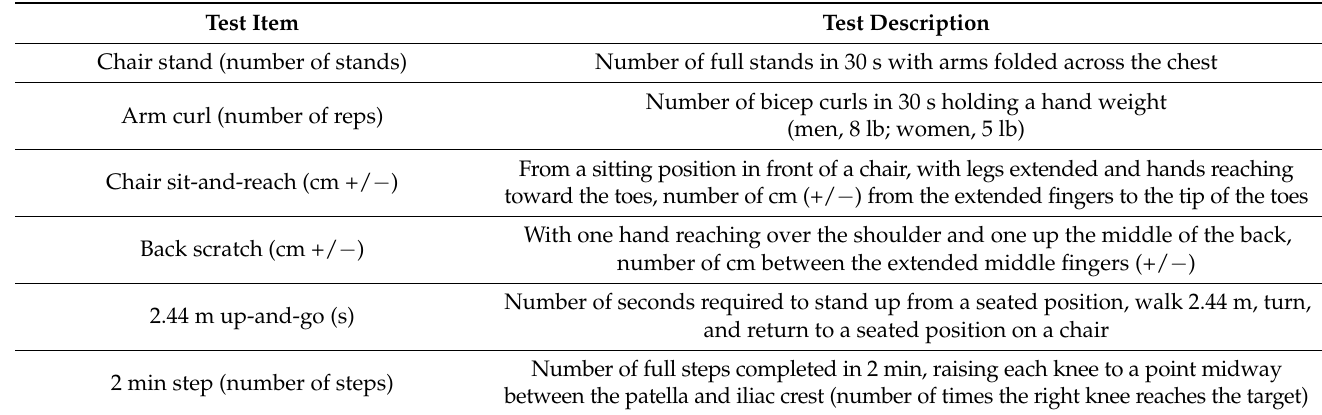
Table 2. Senior fitness